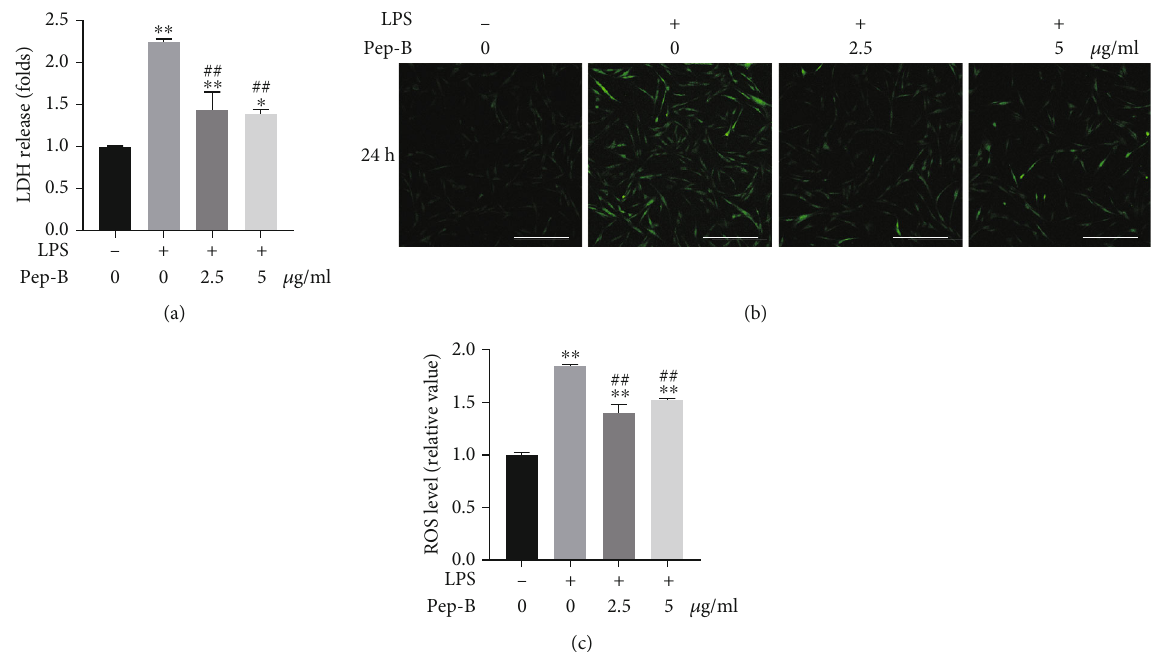
Figure 3: Pep-B ameliorated LPS-induced LDH release and oxidative stress in hDPSCs. Cells were treated with LPS (1 μ g/ml) in the presence or absence of Pep-B (2.5, 5 μ g/ml) for 24 h. (a) The LDH released was determined using a commercial kit. (b) Intracellular ROS was determined by DCFH-DA staining. (c) The stained images were quanti fi ed by fl uorescence density from di ff erent group. ∗ P < 0 : 05 , ∗∗ , ## P < 0 : 01 , ∗ represents comparison with the control group, # represents comparison with the LPS group. Scale bars: 100 μ